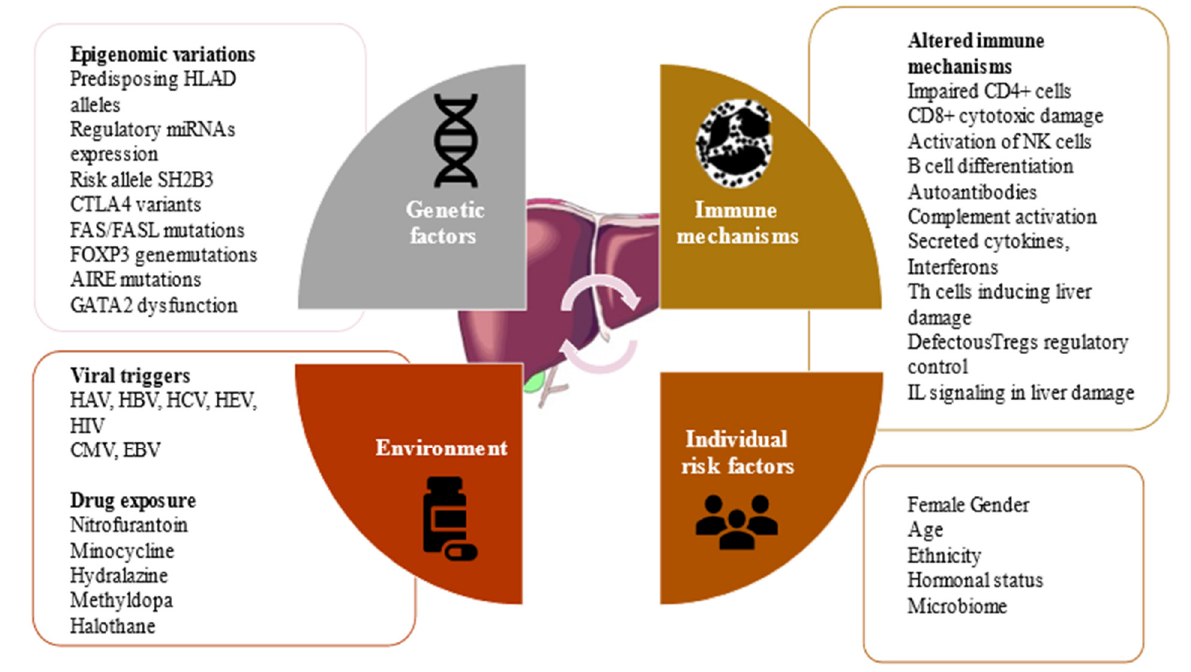
Figure 1. Predisposing factors associated with the risk of developing AIH. Abbreviations: AIRE, autoimmune regulator; CMV, cytomegalovirus; CTLA4, cytotoxic T lymphocyte antigen 4; EBV, Epstein–Barr virus; FAS/FASL, FOXP3, transcription factor forkhead box P3, GATA2, GATA-binding factor type 2; HAV, hepatitis A virus; HBV, hepatitis B virus; HCV, hepatitis C virus; HEV, hepatitis E virus; HIV, human immunodeficiency virus; HLA-D, human leukocyte antigen D allele; IL, interleukin; NK, natural killer cells; SH2B3, gene encoding adaptor protein also known as Lnk; Treg, regulatory T cell.